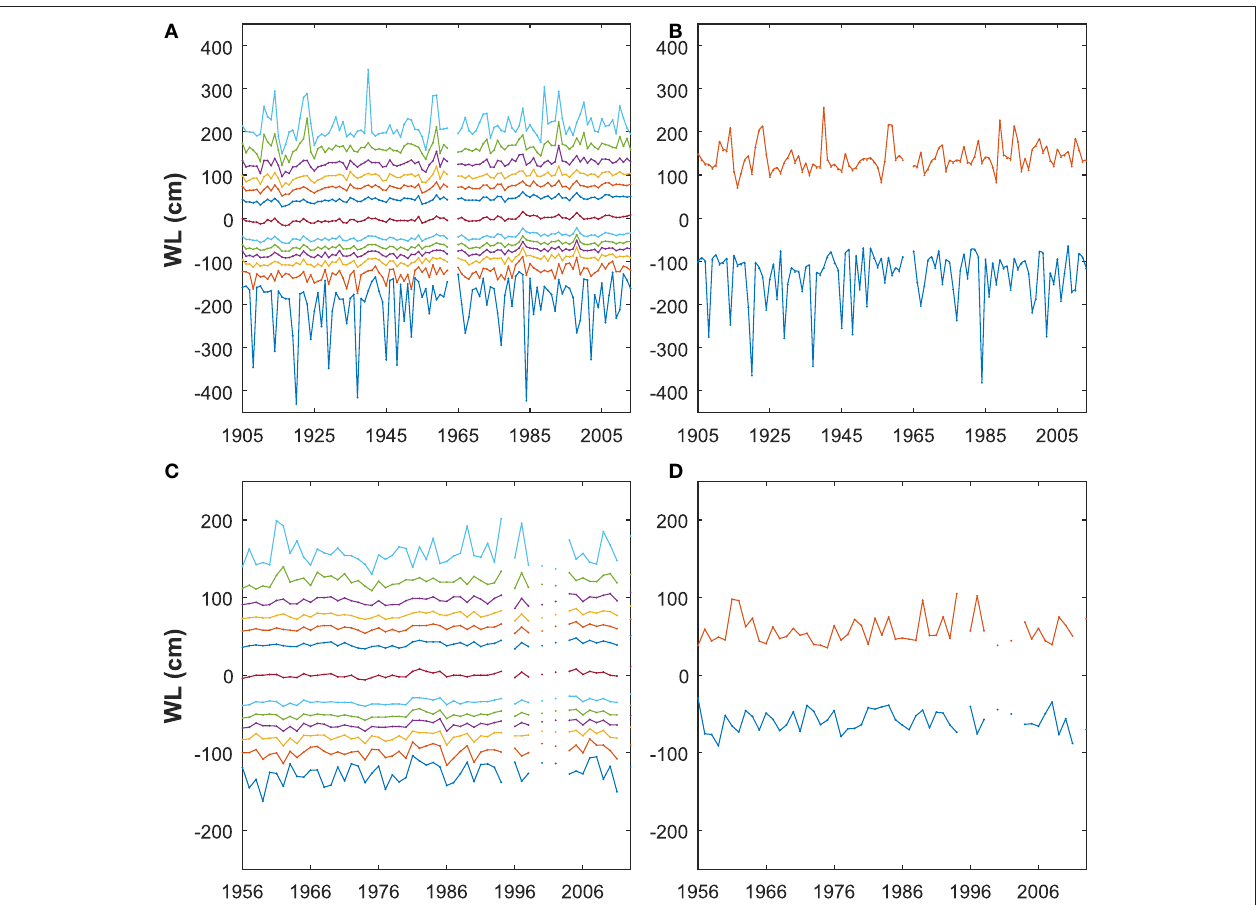
FIGURE 2 | Series of (A) WL percentile series at Buenos Aires (top: 99.5th: bottom: 0.05th), (B) Residual 99.5th (orange) and 0.05th (blue) percentiles series at Buenos Aires, (C) WL percentile series at Mar del Plata (top: 99.5th: bottom: 0.05th), and (D) Residual 99.5th (orange) and 0.05th (blue) percentile series at Mar del Plata.